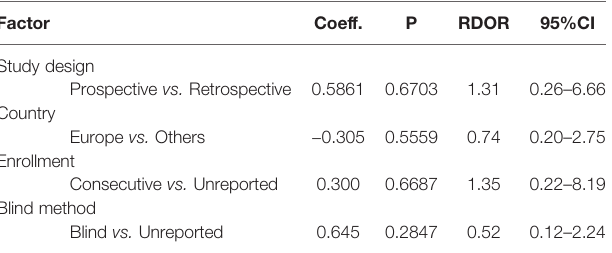
TABLE 3 | Meta-regression